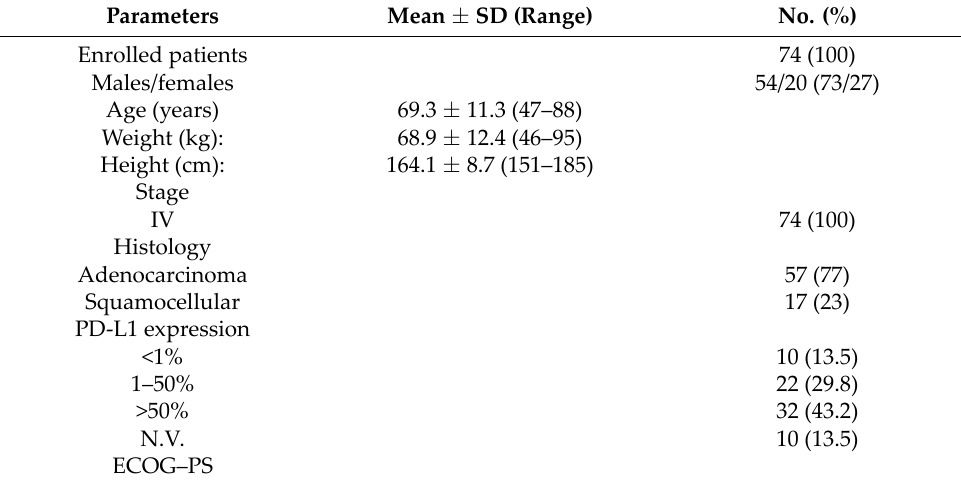
Table 1. Patients’ anthropometric and clinical characteristics at